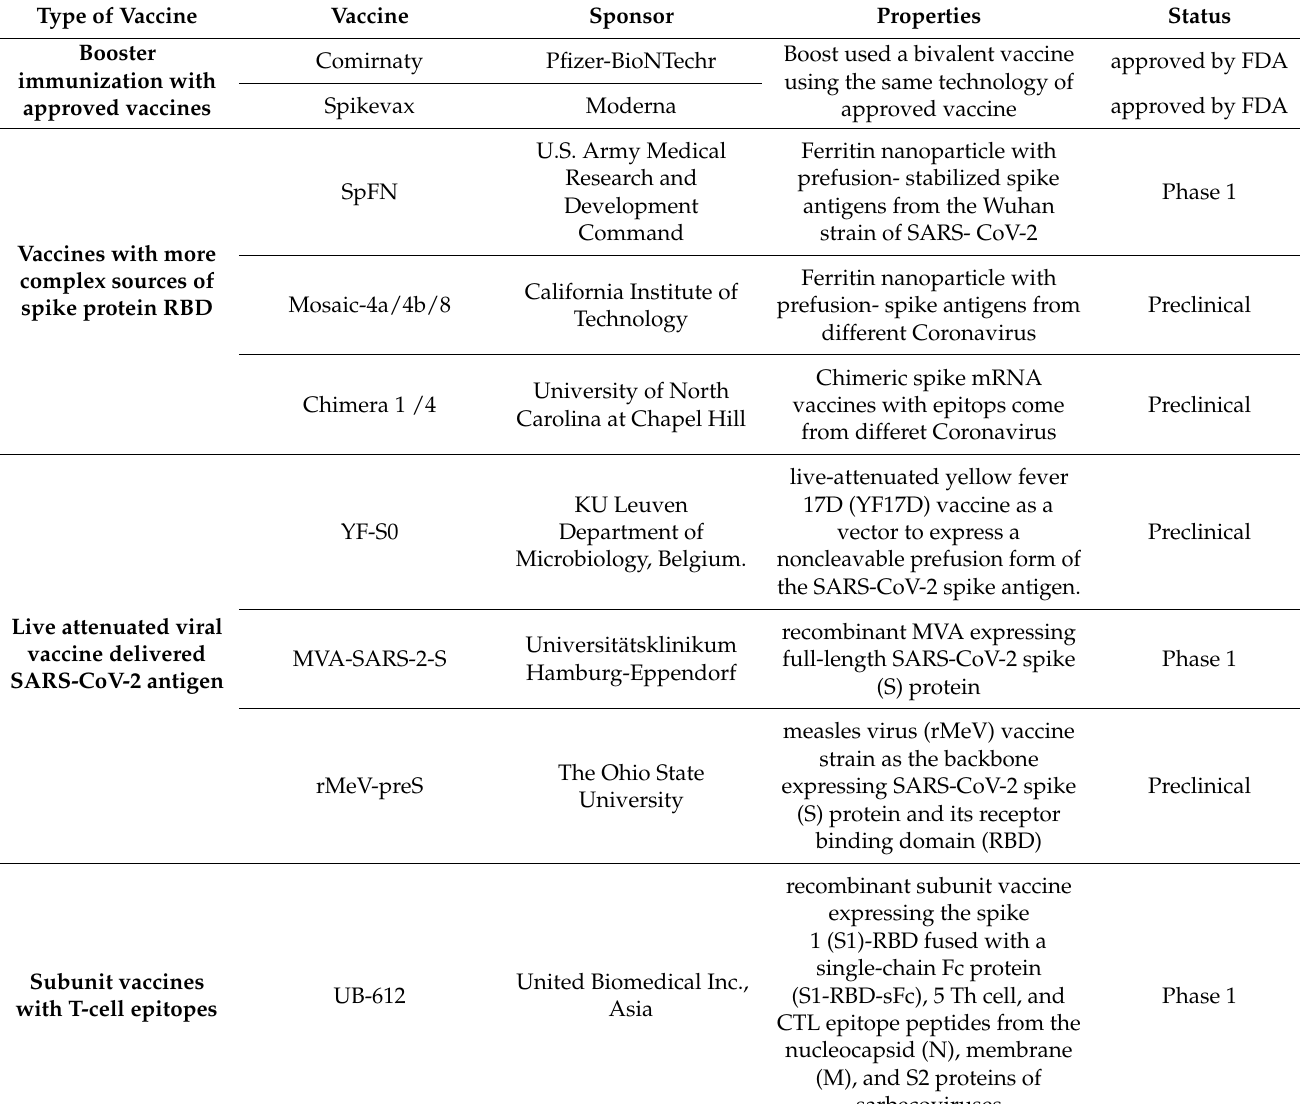
Table 1. Review of next-generation coronavirus vaccines in